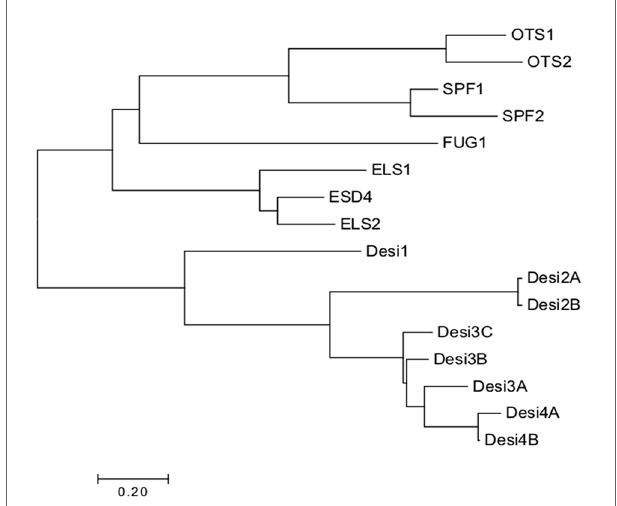
FIGURE 5 | Phylogenetic tree of currently identified SUMO proteases in Arabidopsis. The proteases cluster according to their catalytic triad. Alignments were made using ClustalX and visualized in Jalview. Bootstrap neighbor- Joining trees were made using ClustalX and visualized using